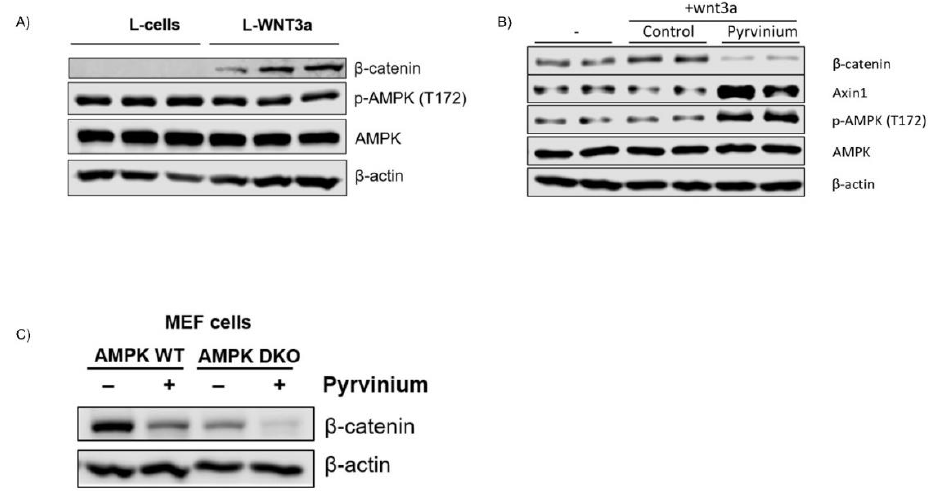
Figure 6. Pyrvinium effect on β -catenin level was independent of its effect on AMPK phosphorylation. ( A ) β -catenin and AMPK phosphorylation in L-cells and L-Wnt3a cells cultured for 24 h. ( B ) Effect of β -catenin upregulation on pyrvinium- induced AMPK activation in HEK293 cells. The cells were cultured with and without WNT3a-conditioned medium and further treated with 100 nM pyrvinium for 24 h. ( C ) Protein expression of β -catenin in AMPK α 1/ α 2 WT and DKO MEF cells treated with and without 100 nM pyrvinium for 24 h. Data are representative of at least three independent experi- ments.